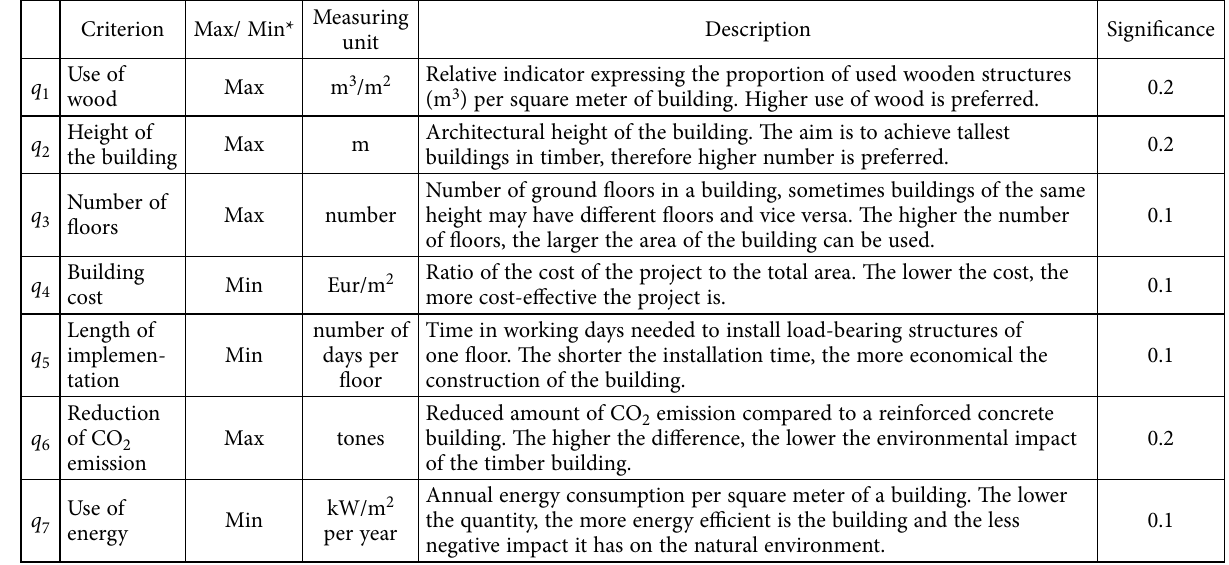
Table 1. Assessment criteria and their significances